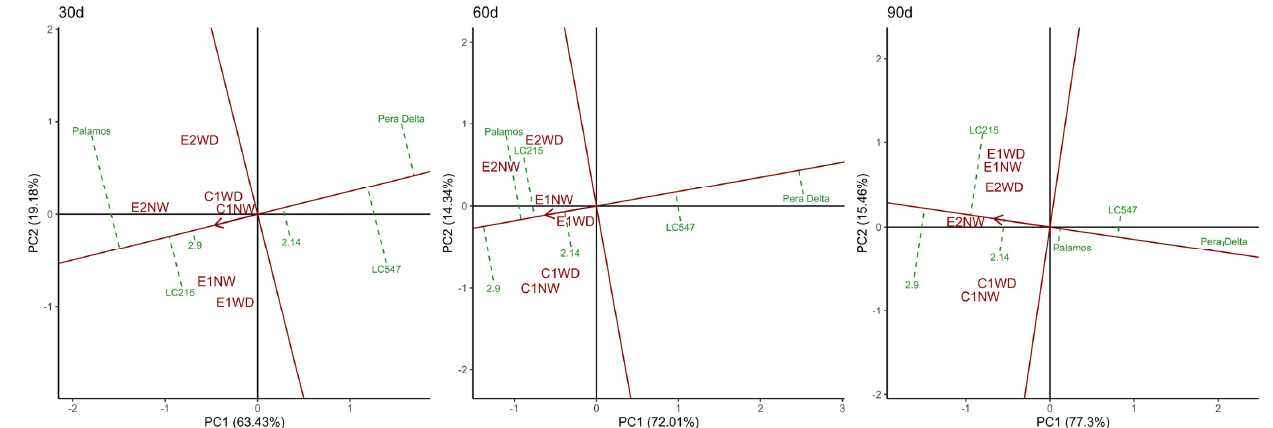
Figure 4. Mean performance vs. stability GGE biplot of the yield after storage (i.e., commercial yield * % shelf life) during the 90-days postharvest period. The single arrowed horizontal line indicates increasing yield after storage, whereas the vertical projections on the line indicate stability. The greater the projection, the higher is the instability. Red, genotypes; green, localities (E1, Eco-1; E2, Eco-2; C1, Conv-1), and irrigation regimes (NW, normal watering; WD, water deficit). Genotypes: 2.9 and 2.14, Penjar breeding lines; LC215 (Penjar) and LC547 (Ramellet), LSL traditional lines; Palamós, Penjar modern hybrid; Pera Delta, processing variety.